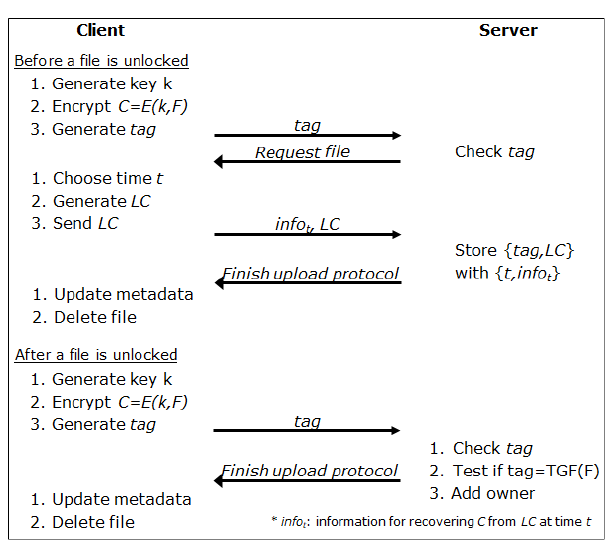
Figure 5. Time-locked deduplication (Basic Construction).